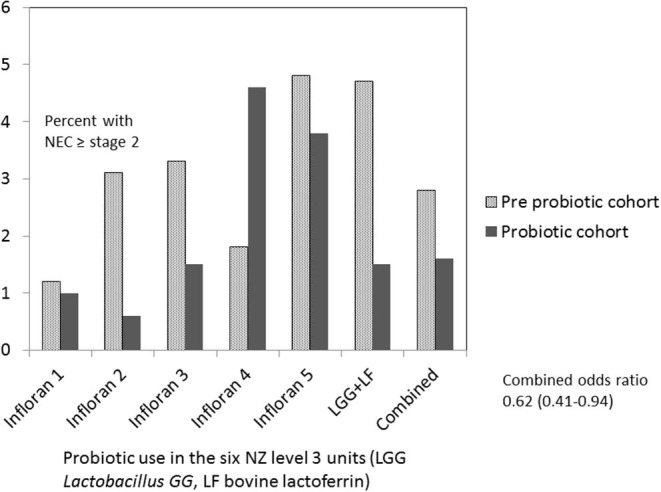
Necrotizing enterocolitis (NEC) <1,500 g or <32 weeks in New Zealand level 3 units before and after probiotics commenced.